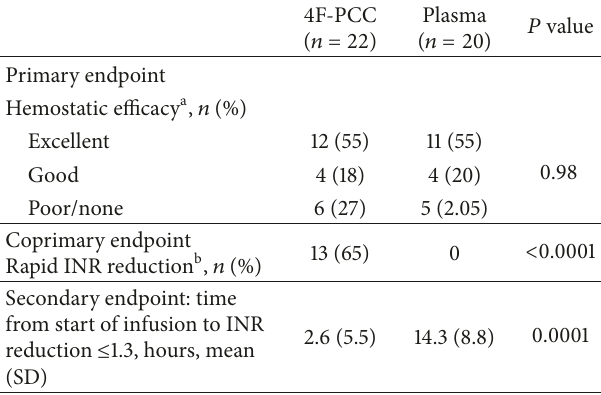
Table 4: Efficacy endpoints from the original phase IIIb